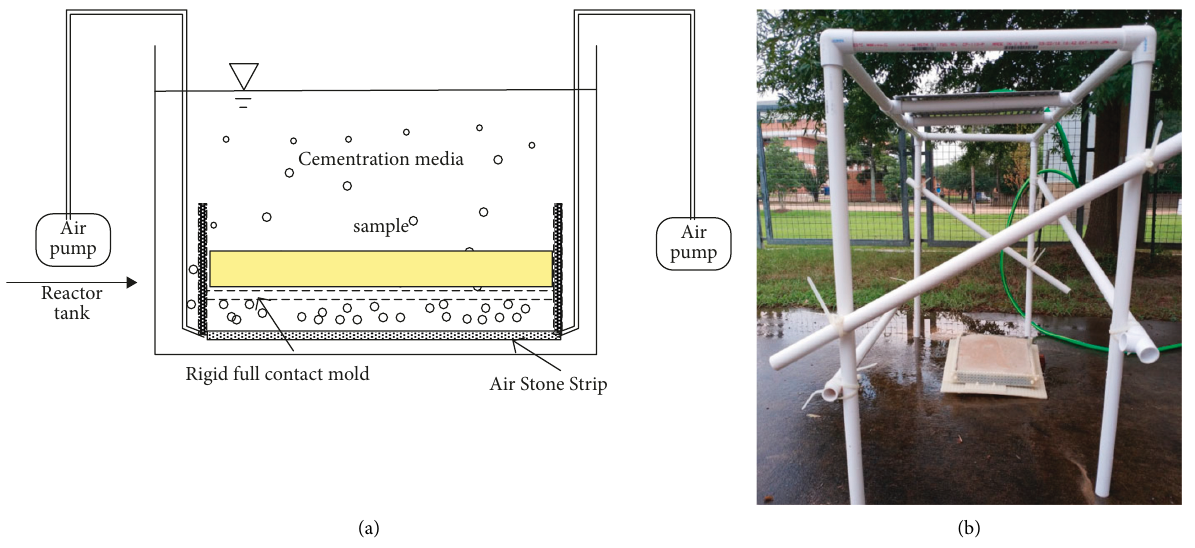
Figure 3: (a) Sketch of batch tank reactor and (b) photo of rainfall simulator and erosion